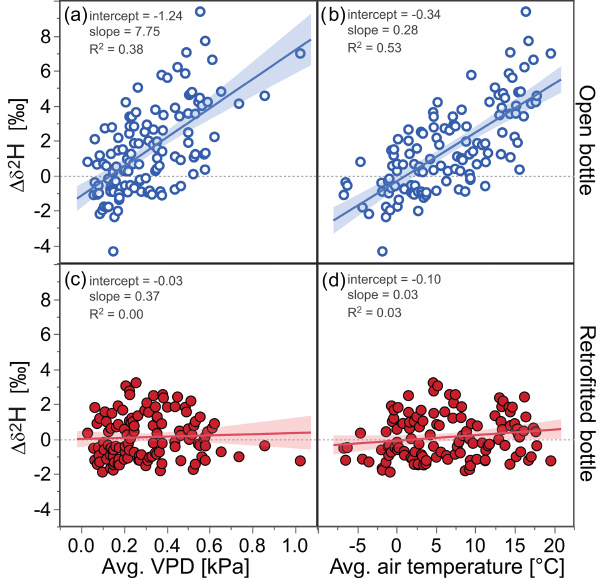
Figure 8. Deuterium differences ( (cid:49)δ 2 H) in samples stored in open and retrofitted ISCO bottles relative to a reference water and their relationships with the maximum changes in relative humidity and air temperature within the respective storage periods at the EIN and ERL sites. Large changes in relative humidity resulted in some isotopic enrichment in samples stored in open bottles (open blue circles) but not in the retrofitted bottles (filled red circles). Sam- ples in open bottles showed the strongest isotopic enrichment when temperature contrasts were large ( > 10 ◦ C), whereas samples in retrofitted bottles seemed to be unaffected by temperature changes. The relationship between the change in air temperature and (cid:49)δ 2 H of samples in open bottles was statistically significant ( r = 0 . 42, p < 0 . 0001). The uncertainties of the individual (cid:49)δ 2 H values were on average 0.52‰; linear regression fits are indicated by solid lines, as well as slope, intercept, and R 2 values; the shaded areas represent the 95% confidence intervals of the fitted